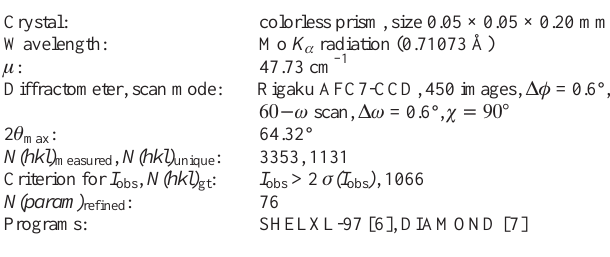
Table 1. Data collection and handling.